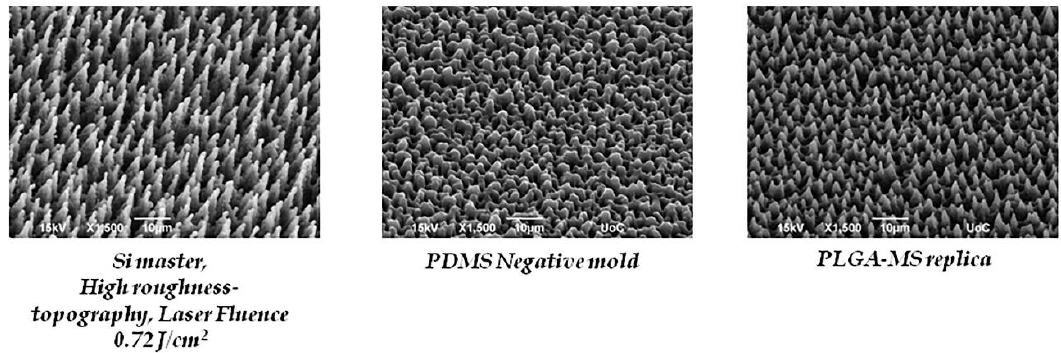
Figure 2. Scanning electron microscopy (SEM) images (tilted view) of a laser-microstructured Si-microspike (MS) substrate (high roughness/topography) mold, poly(dimethylsiloxane) (PDMS) negative mold, and poly(lactide- co -glycolide) (PLGA)-MS replica.